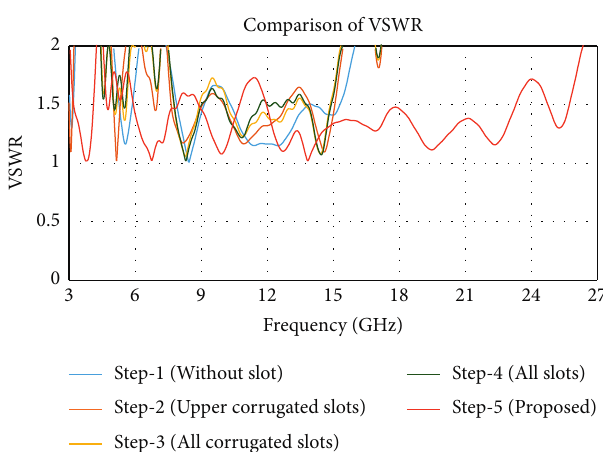
Figure 5: VSWR curve for different evolution